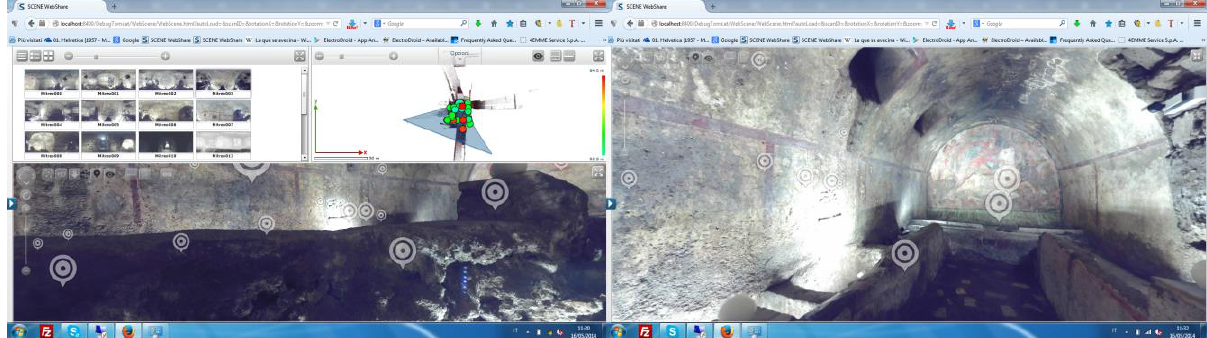
Figure 8. Images of Faro web-Share, software made available by Faro for the use of content on the network. coaxial with the measuring beam of the laser, allows coloring each point acquired with a three-dimensional RGB color value taken from the